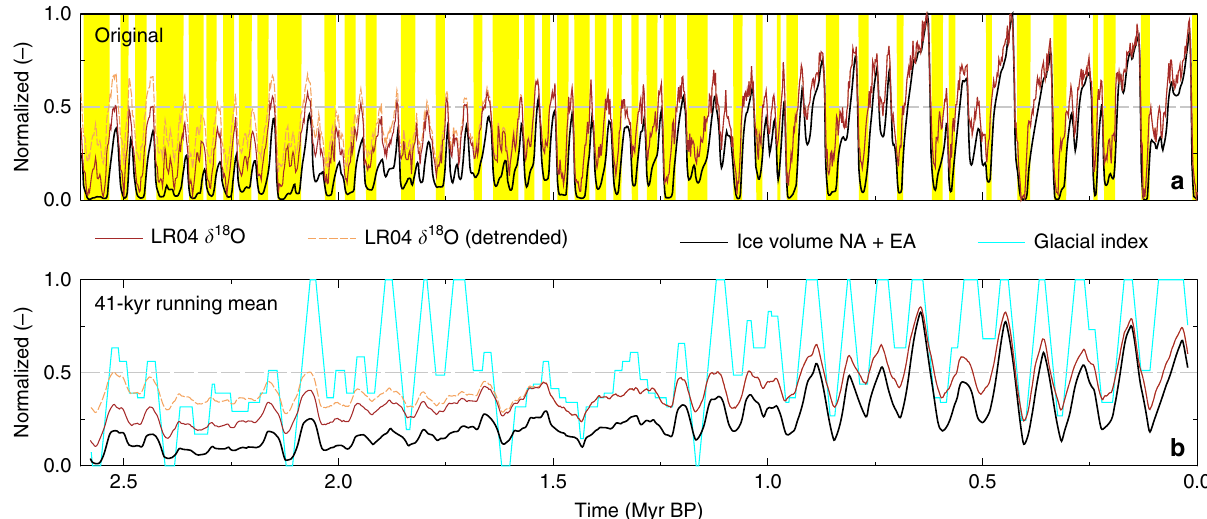
Fig. 5 Indices of Quaternary climate. a Original data including in yellow bars the identi fi ed interglacial periods (this study); b 41-kyr running means. Normalized time series of ice-volume change in North America (NA) and Eurasia (EA) used to de fi ne interglacials (this study) and of the LR04 benthic δ 18 O stack 4 and its detrended version used in T17. In ( b ) the glacial index (the inverse to the yellow interglacial periods contained in ( a )) is shown due to its in-phase dynamics to the other time series. This index is built, when the ice volume in North America and Eurasia is reduced to a binary pattern (glacial = 1; interglacial =